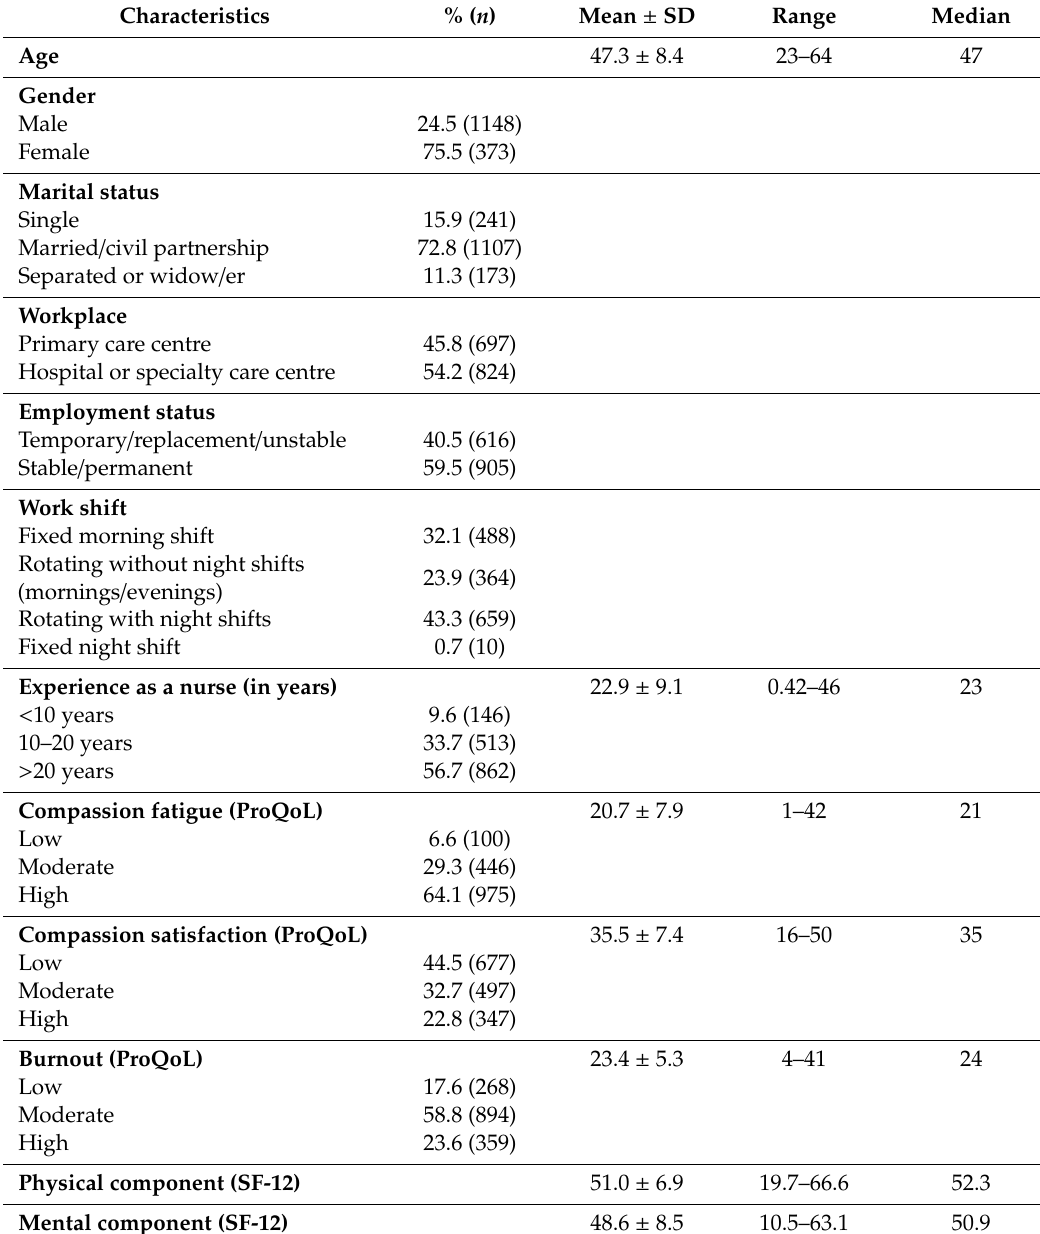
Table 1. Descriptive sociodemographic, work-related and Health-Related Quality of Life (HRQoL_ data of the nurses ( n =